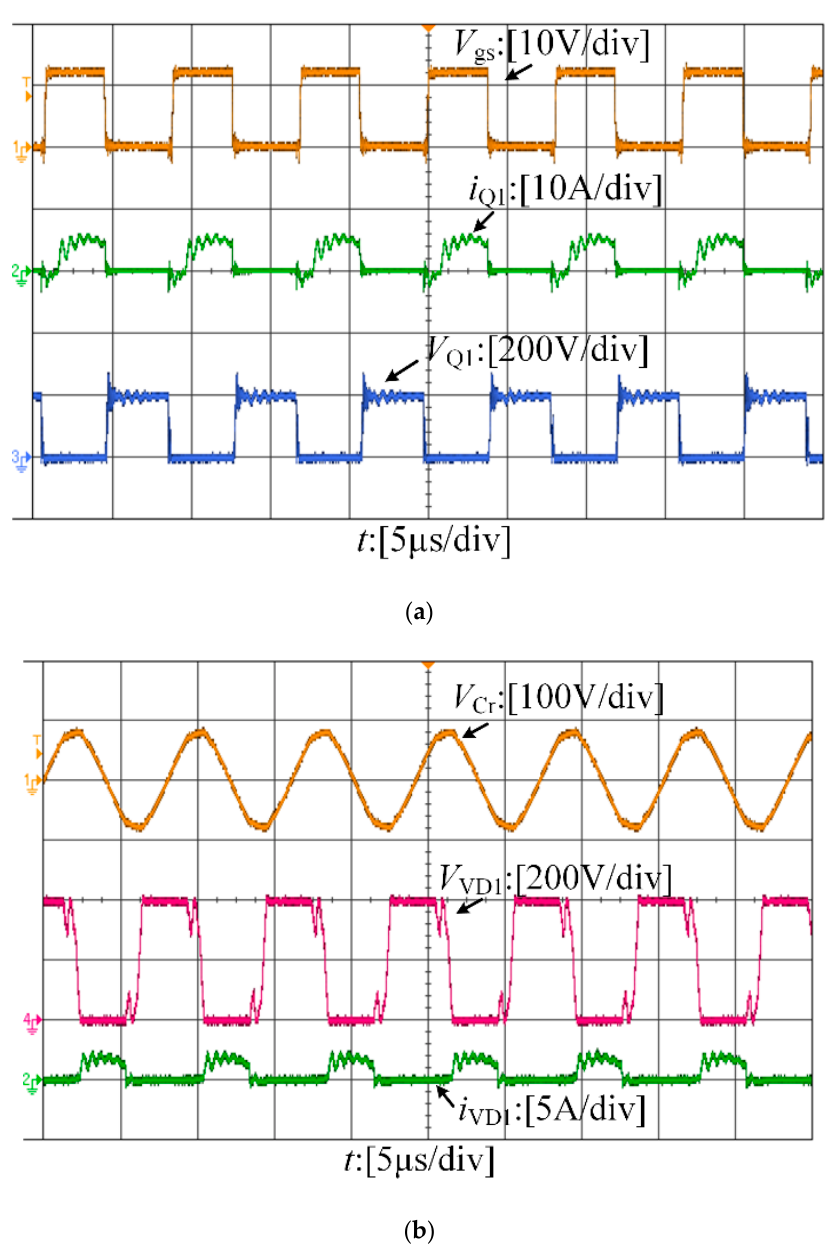
Figure 16. Experimental waveforms at point ③ in mode II. ( a ) Waveforms of Q 1 . ( b ) Waveforms of VD 1 and C r .